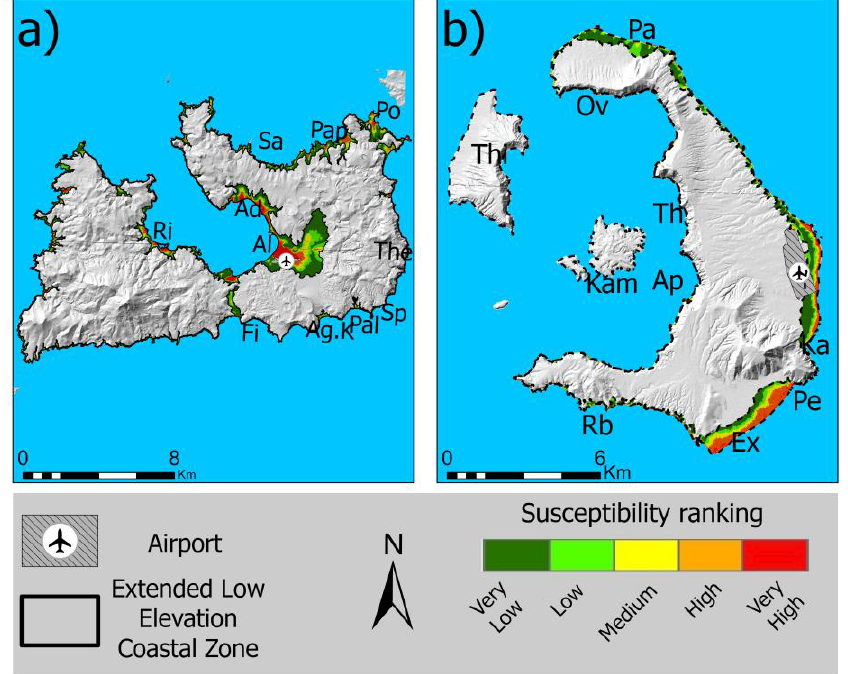
Figure 11. Tsunami susceptibility maps in Milos ( a ) and Thira ( b ) islands.